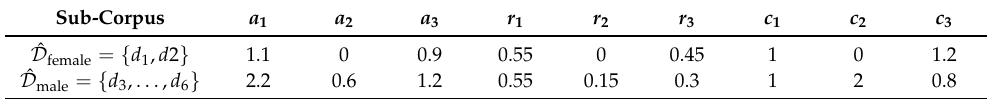
Table 5. Measures for topic allocation in the small example’s sub-corpus of female authors, ˆ D female , and the sub-corpus of male authors, ˆ D male . The three blocks of columns depict for the three topics ( κ = 1, . . . ,3) the absolute topic contribution, a κ ( ˆ D α ) , the relative topic proportion, r κ ( ˆ D α ) , and the topic proportion compared to mean, c κ ( ˆ D α ) ( α ∈ { female,male }